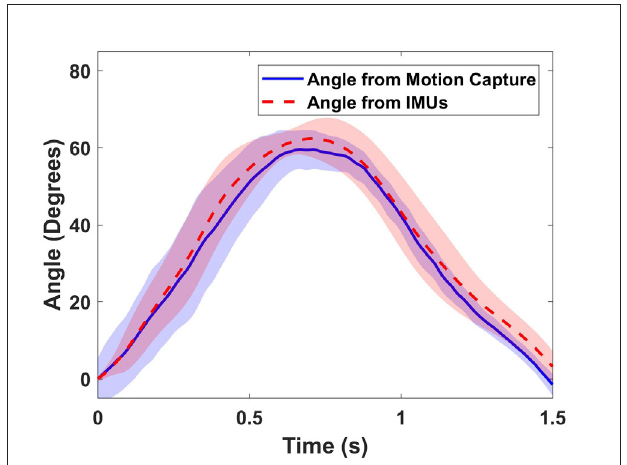
Figure 3 | Joint angle measured by IMU (deg) against measurement from motion capture (deg) averaged for five cycles of operation with standard deviation (RMSE = 0.19 º and error = 0.32%).